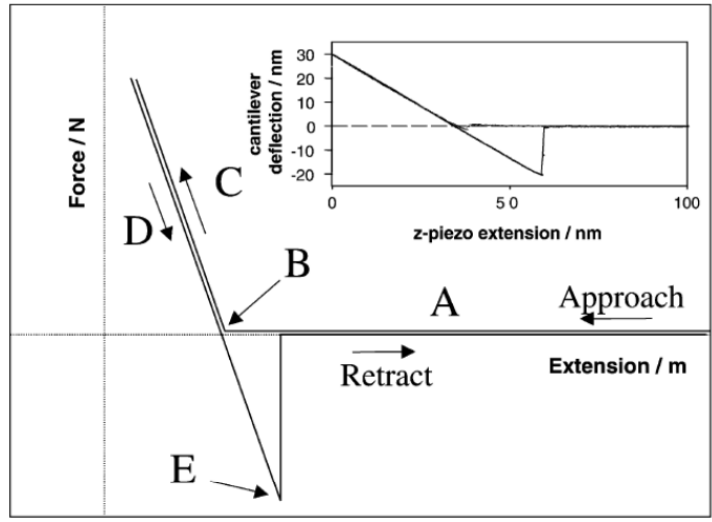
Figure 3. Force-displacement curves were formed. ( A ) tip is a far distance from the surface and there is no interaction; ( B ) the tip contacts the surface; ( C ) the cantilever is bent and a repulsive force (positive) is measured; ( D ) the cantilever holder is retracted from the surface and an adhesive (negative) interaction between the tip and surface is measured; ( E ) the pull-off point (reprinted from [9] with